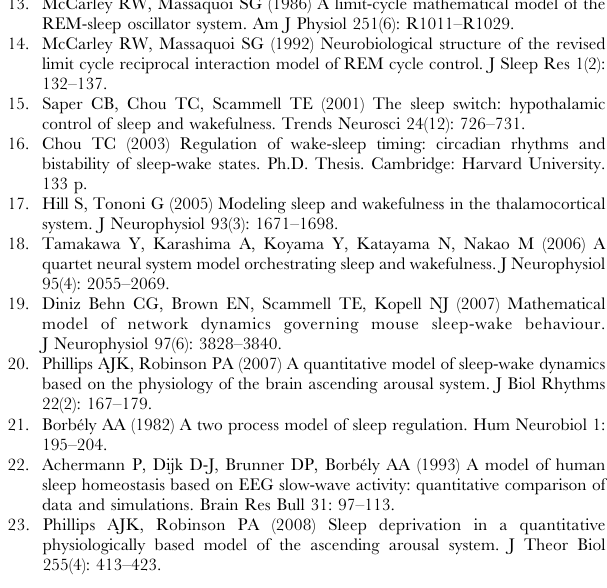
Figure S2 Individual VLPO neurons change their firing rate mode within a few seconds. Example of a VLPO neuron recorded during a sequence of sustained wake (a), wake to NREM transition (b), early NREM sleep (c), late NREM sleep (d) and back to wake (adapted from Szymusiak et al. [31] with kind permission of the publisher). The unit measurement data show the increase in firing rate as the neuron goes from wake (blue) R light sleep (green) R deep sleep (red). We see that transition from one firing mode to another (indicated by an arrow) takes place within a few seconds. (TIF) Table S1 Goodness of fit of the NTP model to the delta sigma and beta time-courses measured by R 2 (%). (DOC) Video S1 A Monte Carlo simulation of neuron transi- tions in the brainstem generating population during one NREM towards and away cycle – according to the NTP model. (MOV) Text S1 Findings at the neuronal level provide elements necessary for the establishment of tenable hypotheses relating the temporal progression of activity at the EEG level to that at sub-cortical